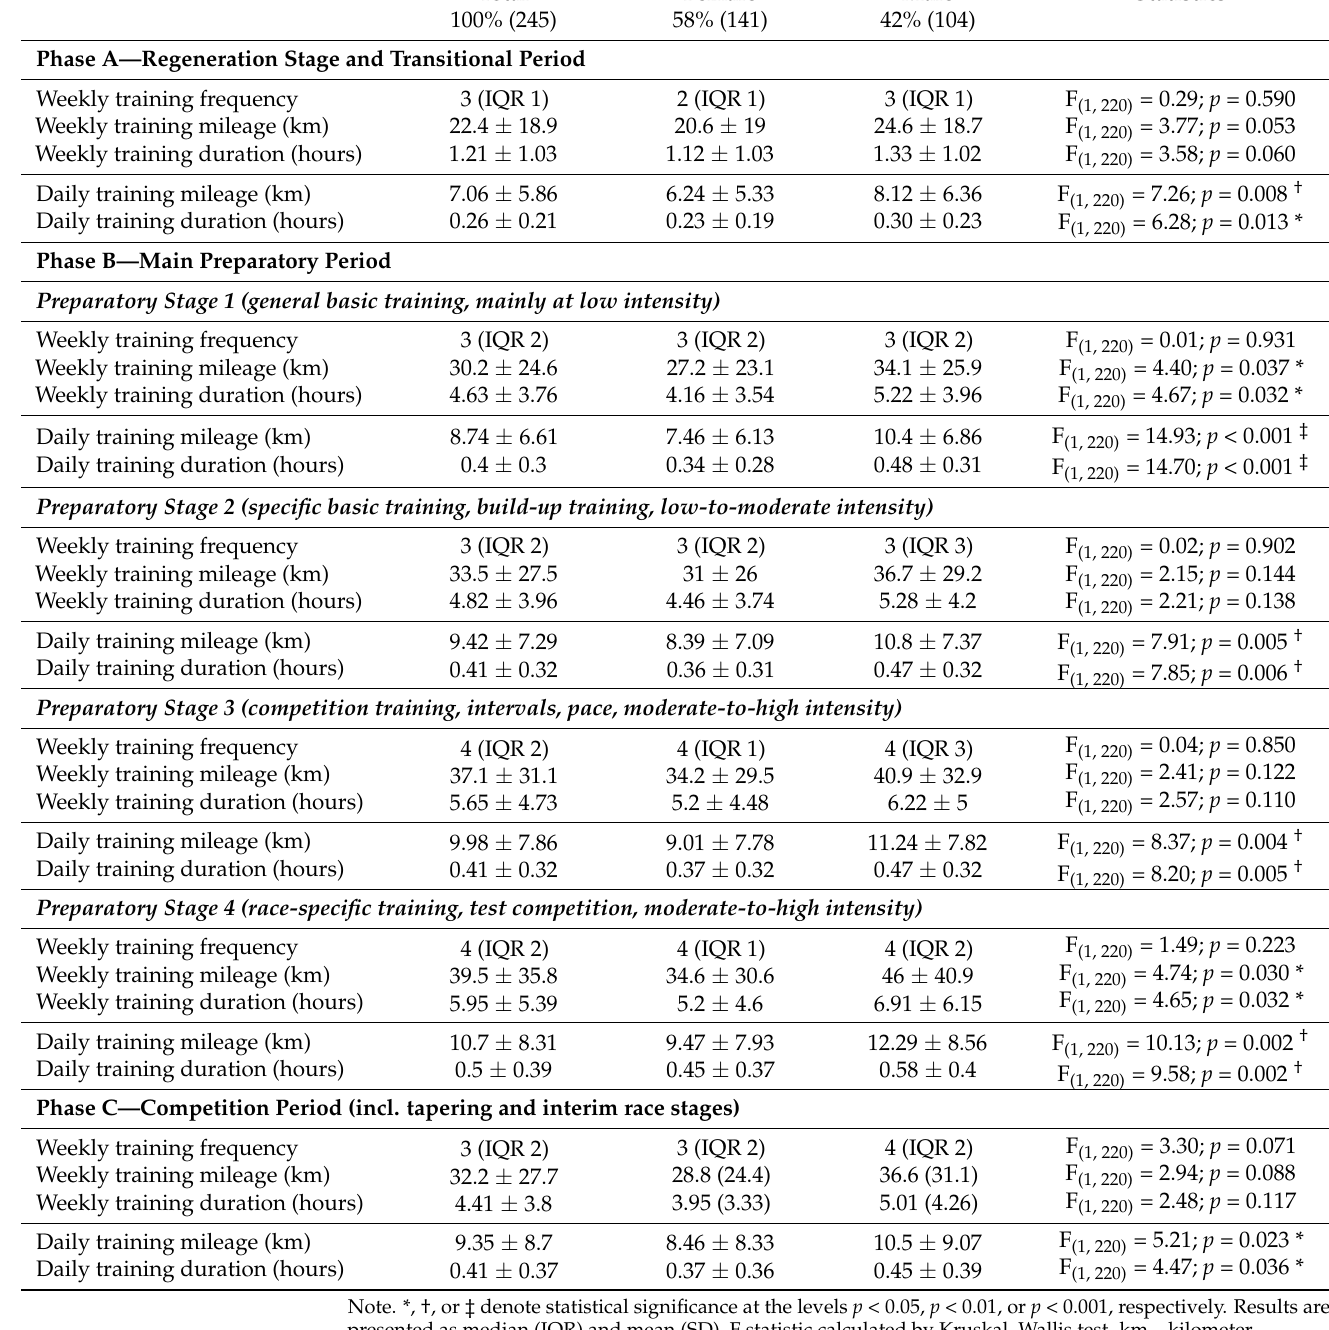
Table 3. Periodization Training Behavior, including Frequency, Mileages, and Durations Displayed by Sex. Total Female Male Statistics 100% (245) 58% (141) 42%